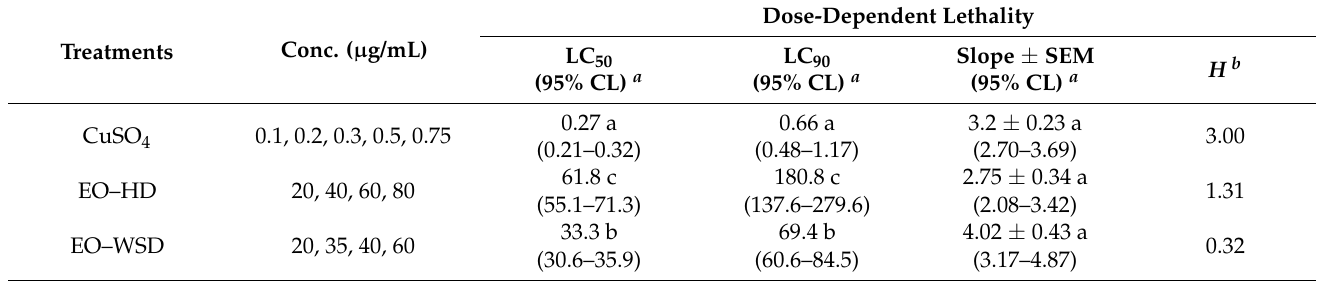
Table 2. Estimated values of lethal concentration of 50 and 90 (LC 50 and LC 90 ) of the essential oils (EOs) of Azorean Cryptomeria japonica leaf obtained by two distillation techniques against adults of Radix peregra, after 24 h of exposure followed by a 24-h recovery period.